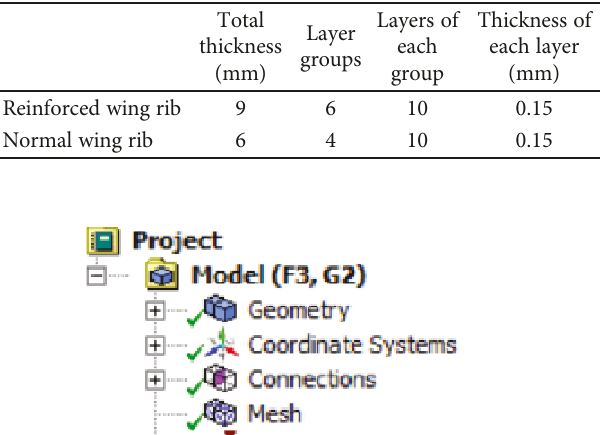
Table 2: Properties of LY12 aluminum alloy.